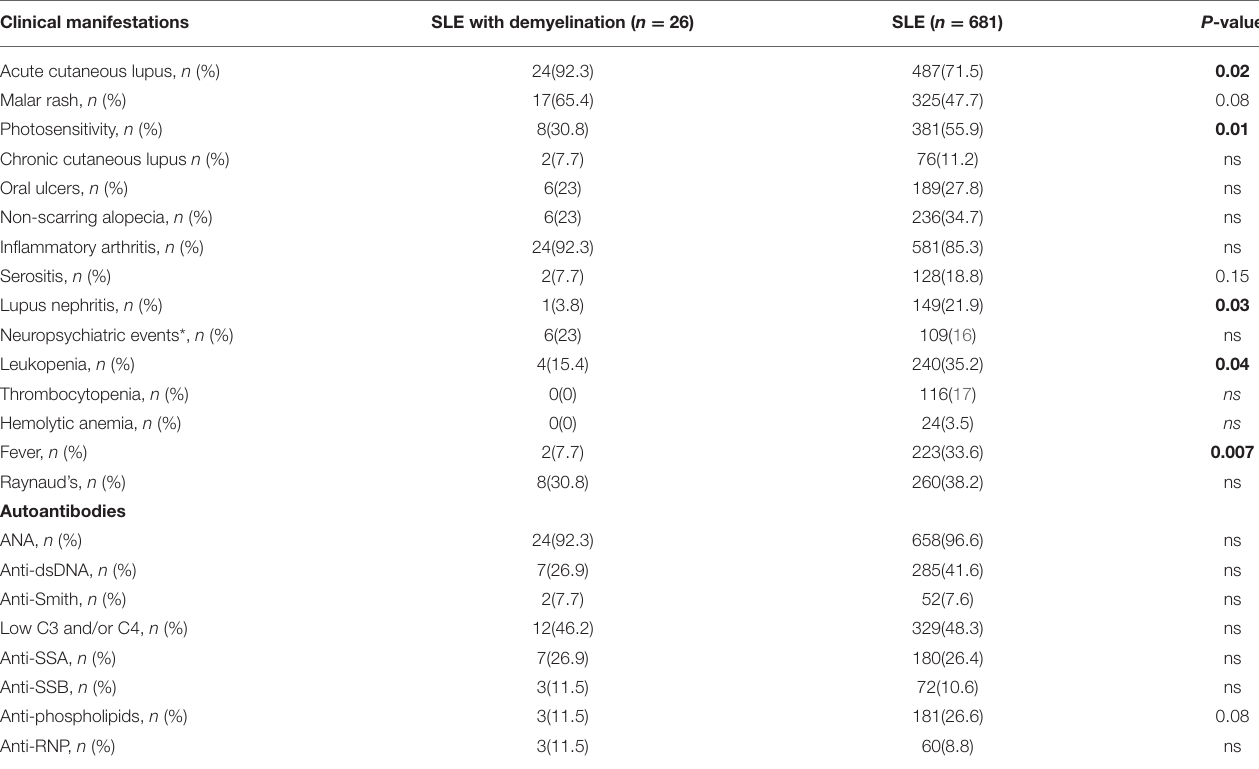
TABLE 1 | Clinical features and autoantibodies in SLE patients with and without demyelinating syndromes. Clinical manifestations